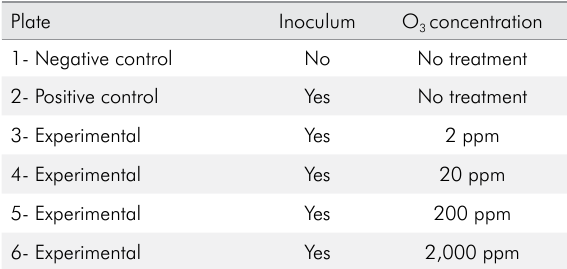
Table 1. Description of each